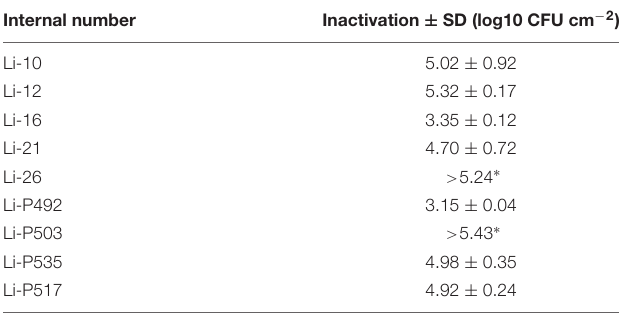
TABLE 3 | Mean reduction (log CFU cm − 2 ) and standard deviation of L. monocytogenes viable counts on Tryptone Soya Agar supplemented with Yeast Extract when exposed to sublethal PL stress of 0.46 J cm − 2